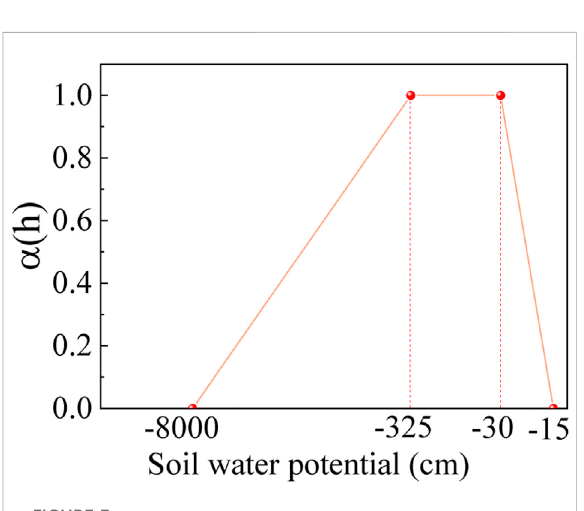
FIGURE 3 Functionofsoilwaterpotentialonrootwaterabsorptionrate.